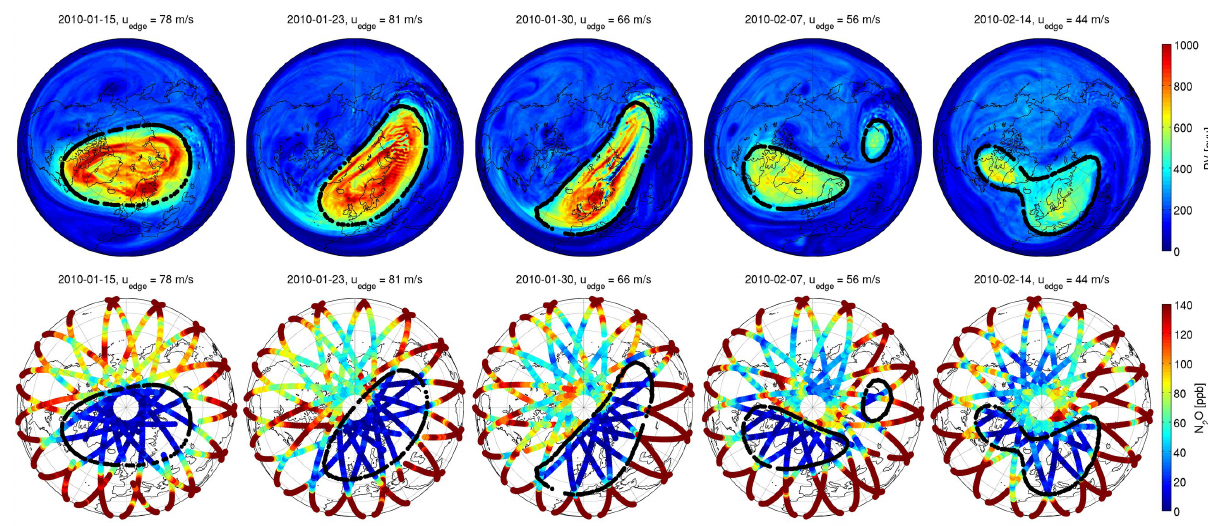
Fig. 3. As in Fig. 1, but on the 800K isentropic surface (approximately 10hPa) and showing Aura MLS N 2 O VMR [parts per billion, ppb] instead of H 2 O in the lower